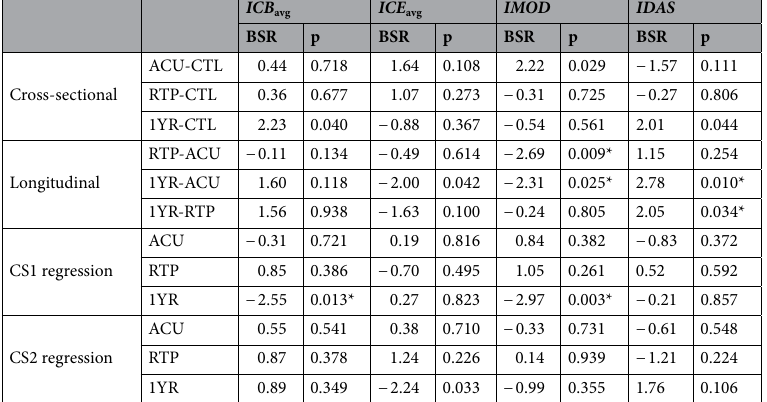
Table 3. Effects of concussion on integrated measures of mean betweenness centrality ( ICB avg ), mean eigenvector centrality ( ICE avg ), modularity ( IMOD ) and degree assortativity ( IDAS ), for concussed athletes at acute injury (ACU), return to play (RTP) and one year post-RTP (1YR). This includes cross-sectional differences relative to controls (CTL) and within-subject longitudinal changes between imaging sessions. Tables report bootstrap ratios (BSRs) and p-values. Significant effects at an FDR threshold of 0.05 are noted with